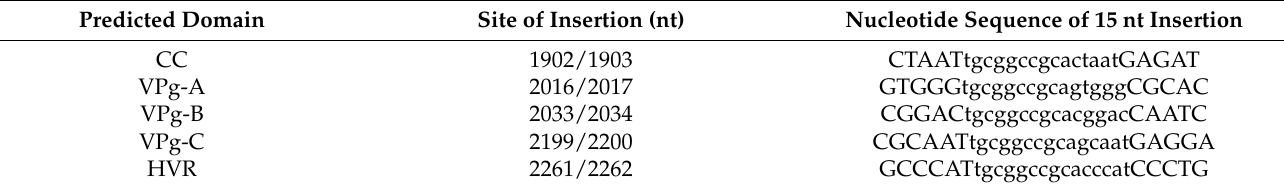
Figure 2. Identification of 15 bp insertion sites in the ORF1a coding region of PAstV. Schematic diagram showing the transposon-based random insertion. MuA transposase-mediated random insertion was concentrated in a specific region of the PAstV genome, an HpaI-to-HindIII fragment containing half of the C-terminal of the coiled-coil structure, as well as the predicted genome-linked protein, VPg, and the hypervariable region. Table 1. Positions of the 15 nt insertions in the ORF1a coding